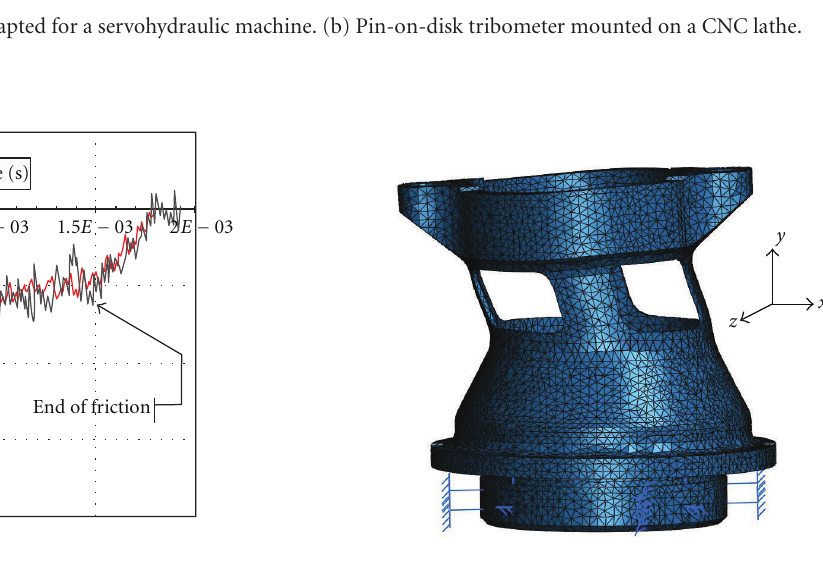
Figure 4: Typical signal obtained on the ballistic device ( V = 35m / s, P a = 40MPa).